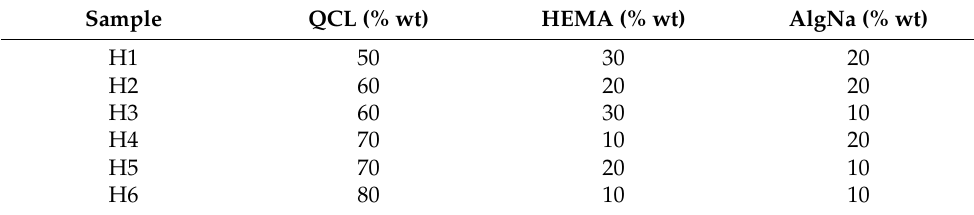
Table 4. Composition in a reaction mix of different hydrogels (total mass 2